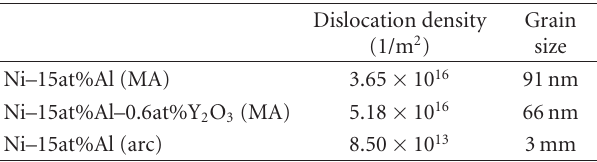
Table 1: Dislocation density and grain size of as-fabricated specimens produced by mechanical alloying and